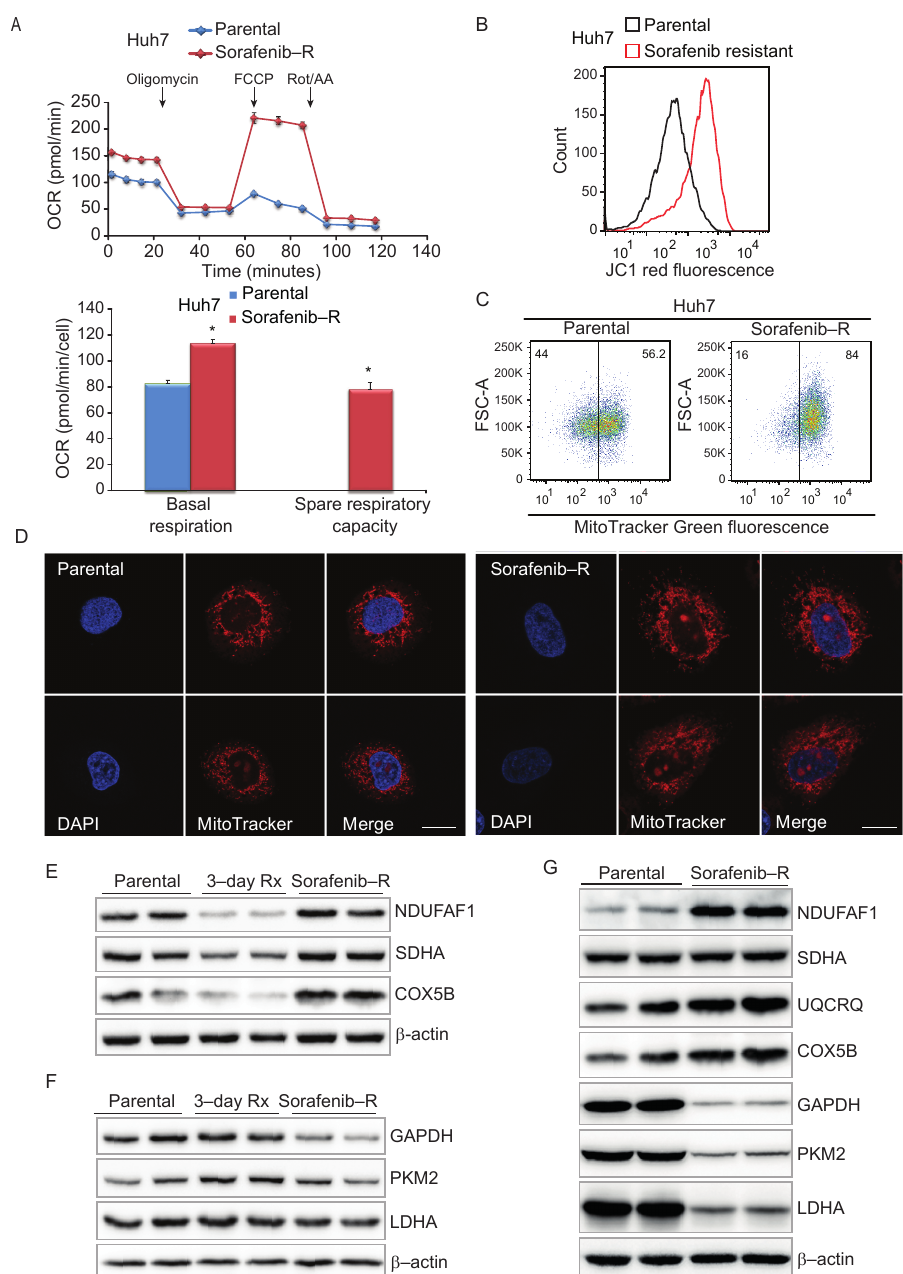
Figure 3. Increased mitochondrial activity in sorafenib resistant Huh7 cells. ( A ) Mitochondrial oxygen consumption rate (OCR) in sorafenib-resistant and parental Huh7 cells determined by Seahorse XFp analyzer and mitochondrial stress test. ( Top ) Real-time OCR measurements normalized to cell number. ( Bottom ) Basal and spare respiratory capacity based on OCR profiles. *, p ≤ 0.005. ( B ) Mitochondrial membrane potential (MMP) assessed by JC-1 staining (JC-1 red fluorescence) and flow cytometry in sorafenib-resistant and parental Huh7 cells. ( C ) MitoTracker Green staining and mitochondrial mass assessment by flow cytometry in sorafenib-resistant and parental Huh7 cells. ( D ) Mitochondrial morphology in parental ( left panels) and sorafenib-resistant ( right panels) Huh7 cells stained with MitoTracker Orange (mitochondria) and DAPI (nuclei) and examined by confocal microscopy. Representative images at 20 × magnification. Bar, 10 µ m. ( E ) Protein levels of constituents of mitochondrial respiratory complexes in parental, sorafenib-resistant (sorafenib-R) and parental Huh7 cells treated with sorafenib (7.5 µ M) for three days (3-day Rx). ( F ) Protein levels of glycolytic enzymes in parental, sorafenib-resistant (sorafenib-R), and parental Huh7 cells treated with sorafenib (7.5 µ M for three days; 3-day Rx). ( G ) Expression of mitochondrial complex proteins and glycolytic enzymes in parental and sorafenib-resistant colonies isolated after 3-week continuous exposure to